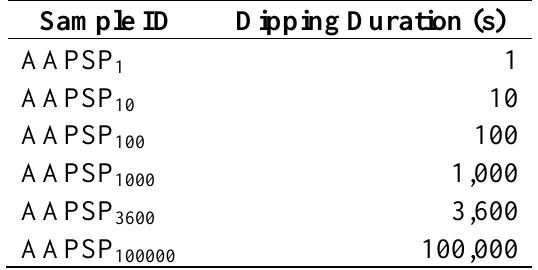
Table 1. Dipping conditions of AA-PSP. Bathophen ruthenium was chosen as a luminophore and dichloromethane was chosen as a solvent. The luminophore concentration was fixed at 0.1